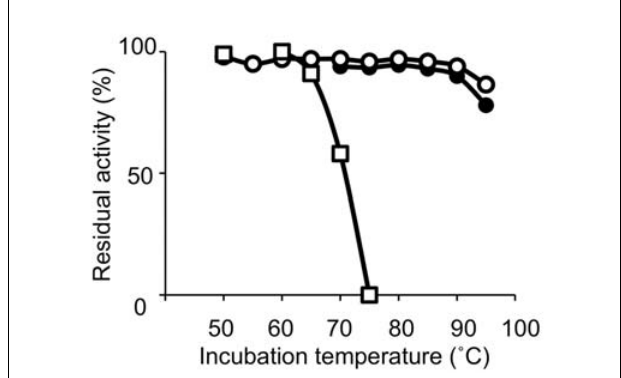
FIGURE 1 | Heat resistance of the DNA polymerases. Residual DNA polymerase activities after incubation at the indicated temperature for 30 min were plotted. DNA polymerases from Pyrococcus furiosus (open circles), Thermus aquaticus (closed circles), and Bacillus caldotenax (open squares) were used as representatives from hyperthermophiles, extreme thermophiles, and moderate extremophiles, respectively.